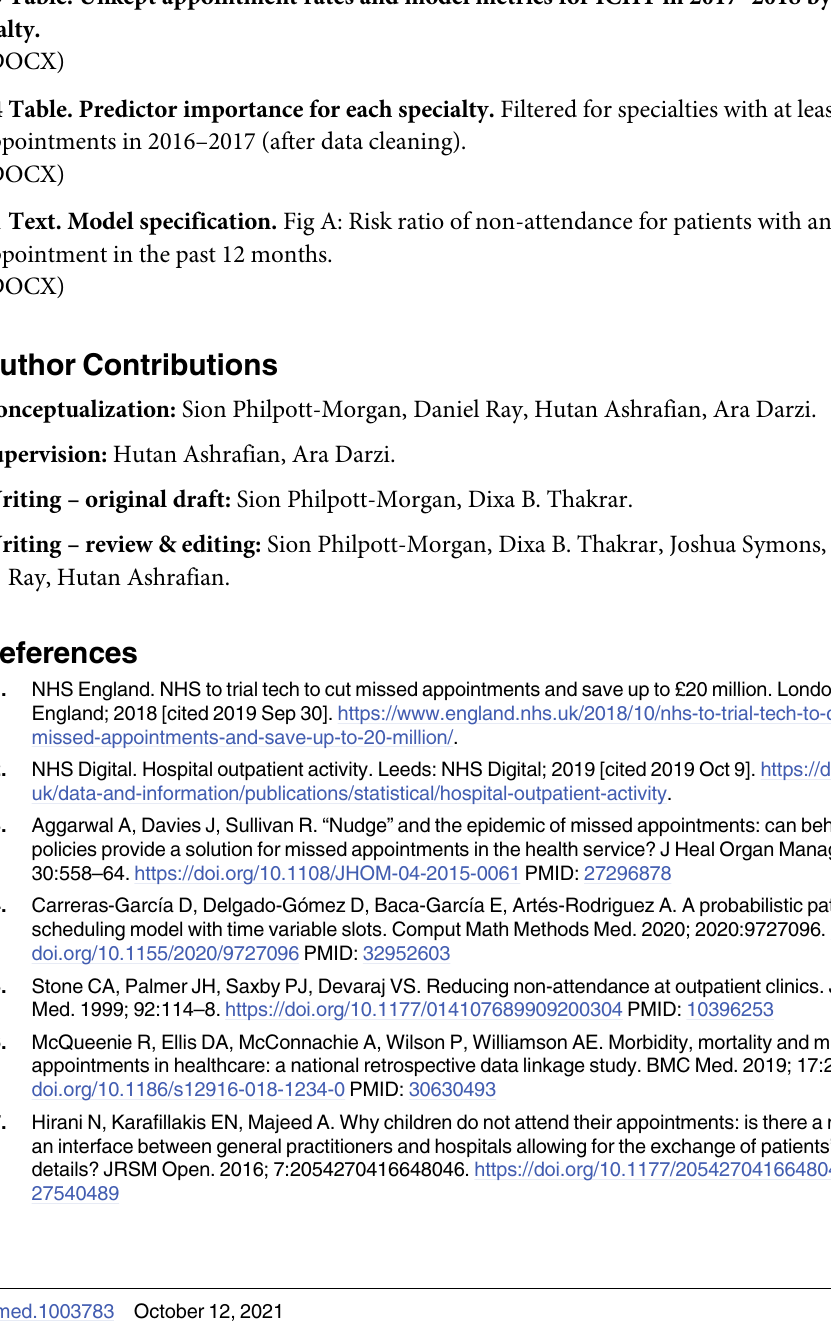
S4 Table. Predictor importance for each specialty. Filtered for specialties with at least